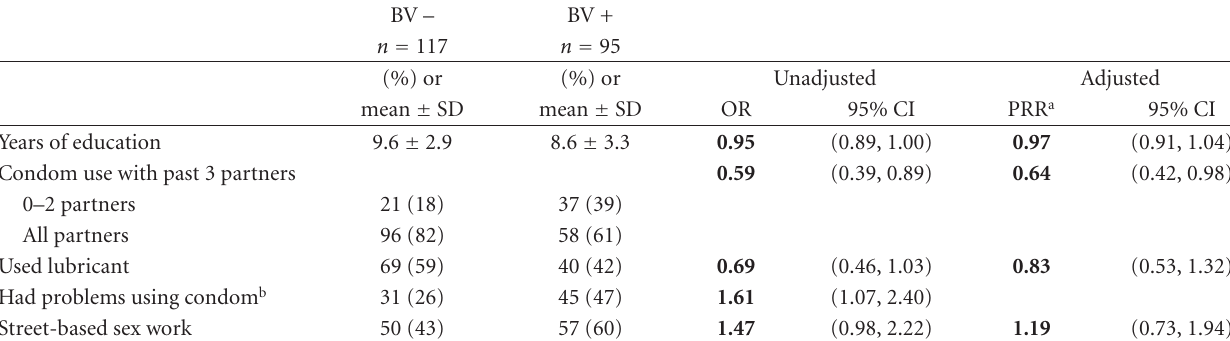
Table 4: Unadjusted and adjusted analyses of relationships between individual behavioral characteristics and risk of bacterial vaginosis among 212 clandestine female sex workers: Lima, Peru,